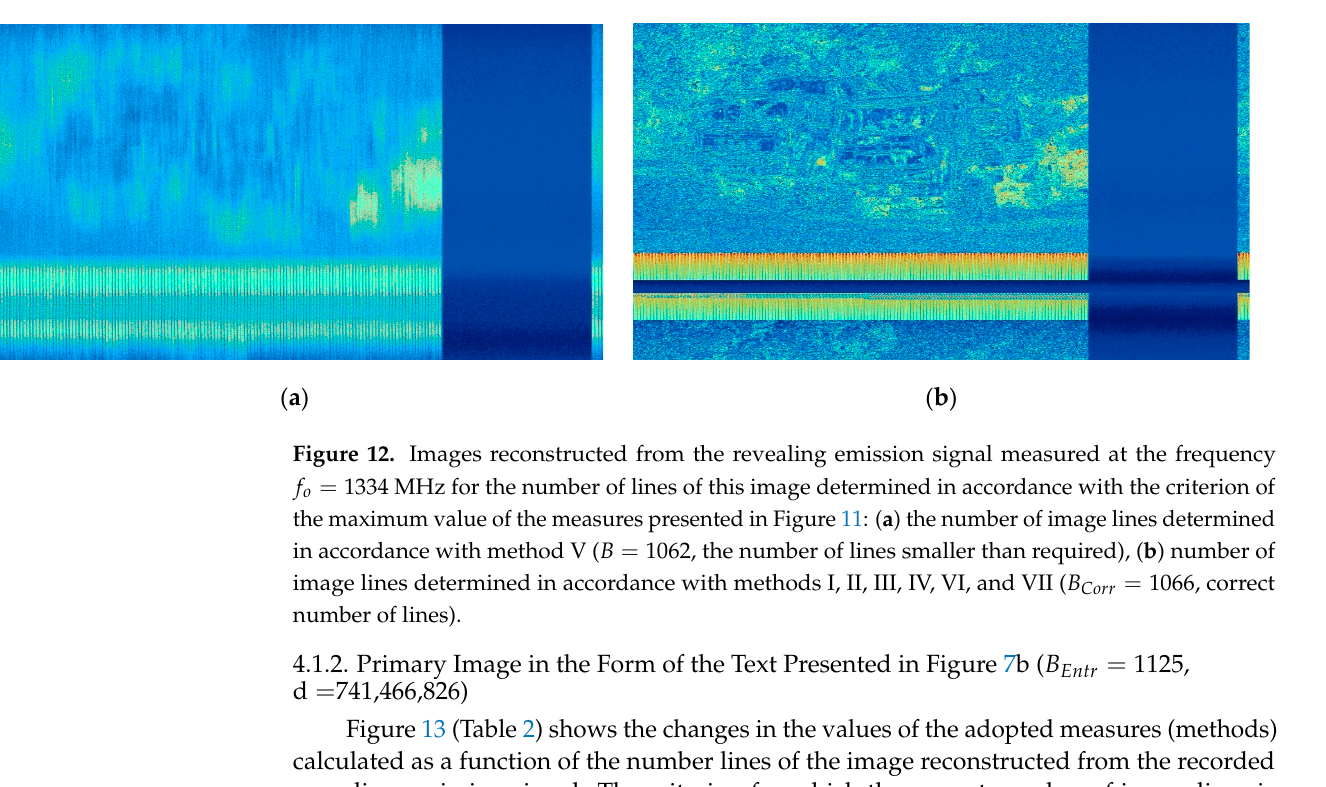
Figure 12. Images reconstructed from the revealing emission signal measured at the frequency 𝑓